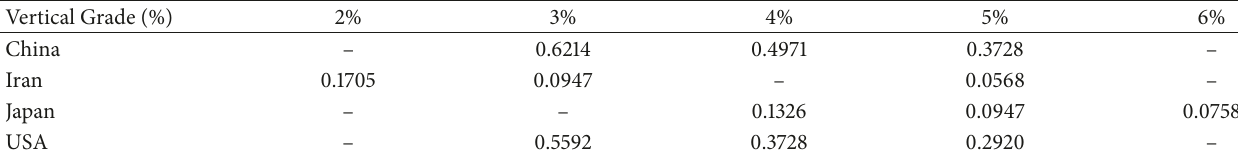
Table 3: Maximum length (mi) for a certain grade with design speed of